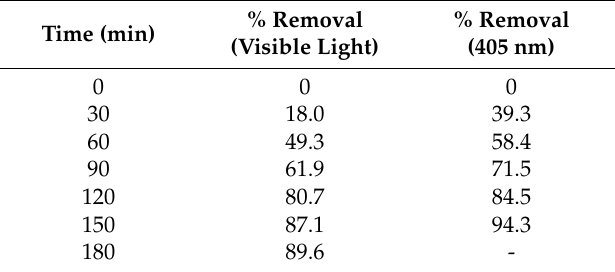
Concentration of MO at each reaction time was obtained from the maximum in absorbance at 464